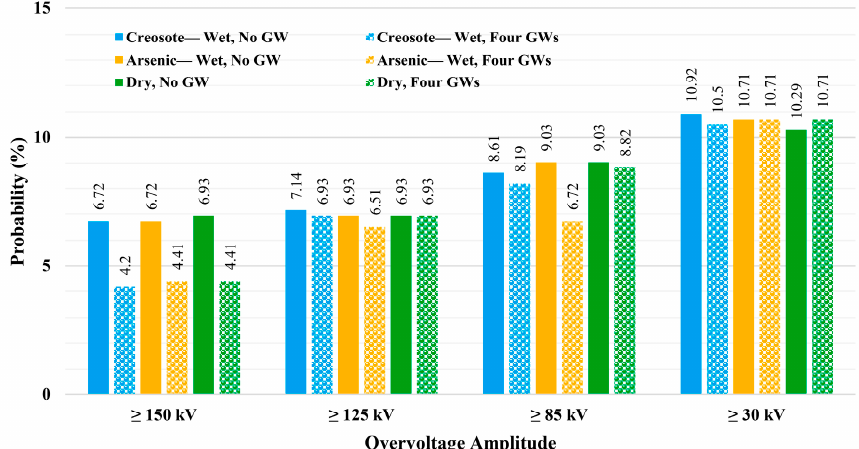
Figure 4. Comparison among the probabilities of transformers experiencing four overvoltage stress levels for three configurations of the network with no guy wire (No GW) and four guy wires (Four GWs).